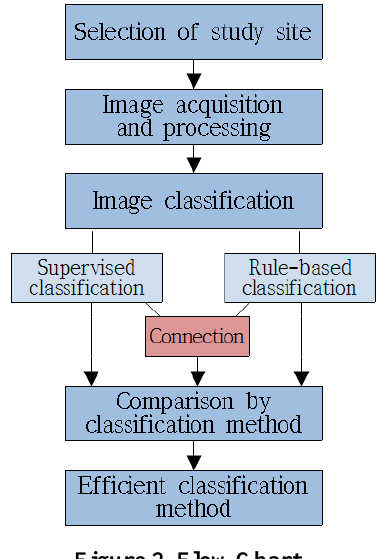
Figure 2. Flow Chart